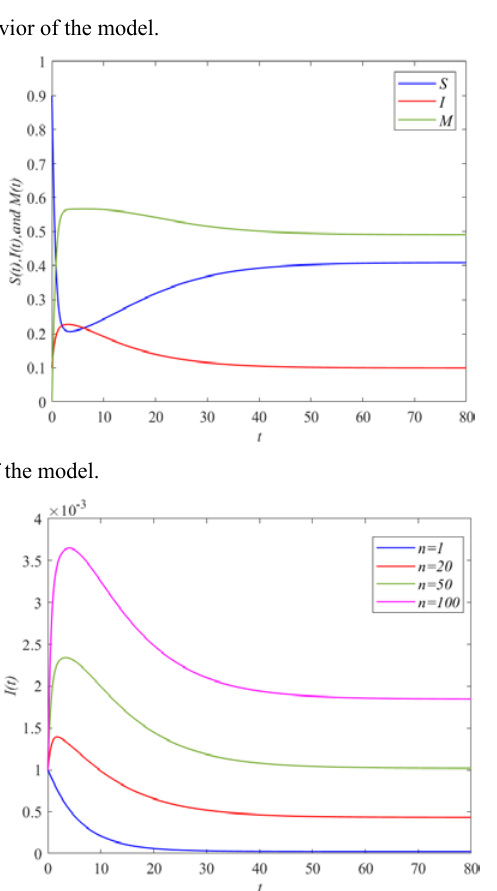
Fig.4. Evolution of infected nodes with different node degree